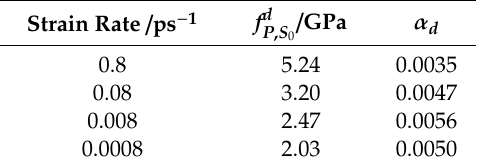
Table 5. The parameters fitted by Equation (6) in Figure